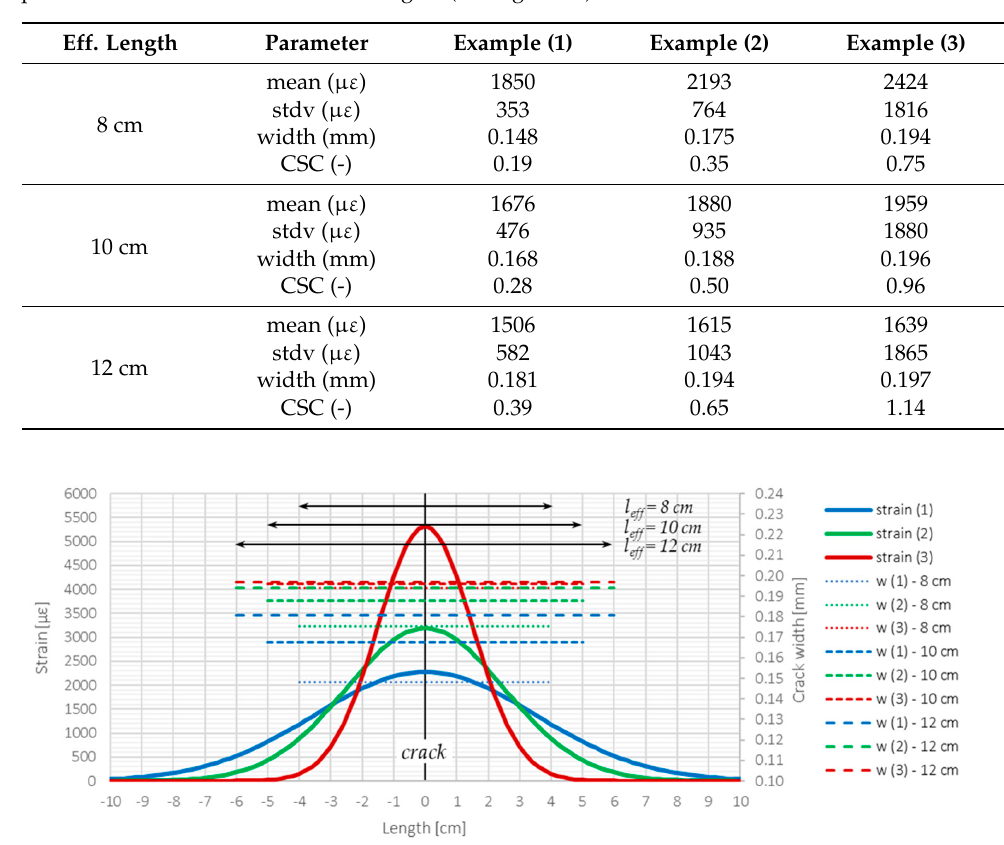
Table 4. Statistical parameters of individual cracks calculated based on the three example strain profiles for three different effective lengths (see Figure 26).